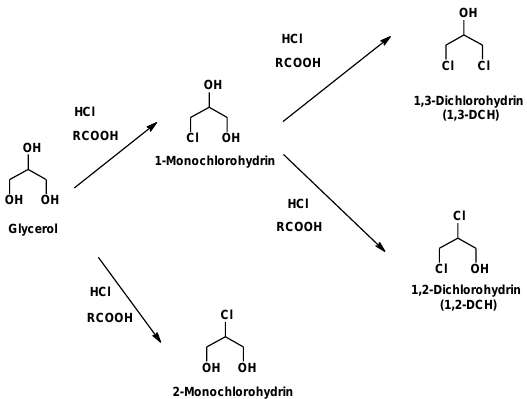
Figure 2. Syntesis of DCH by two-step glycerol hydrochlorination.